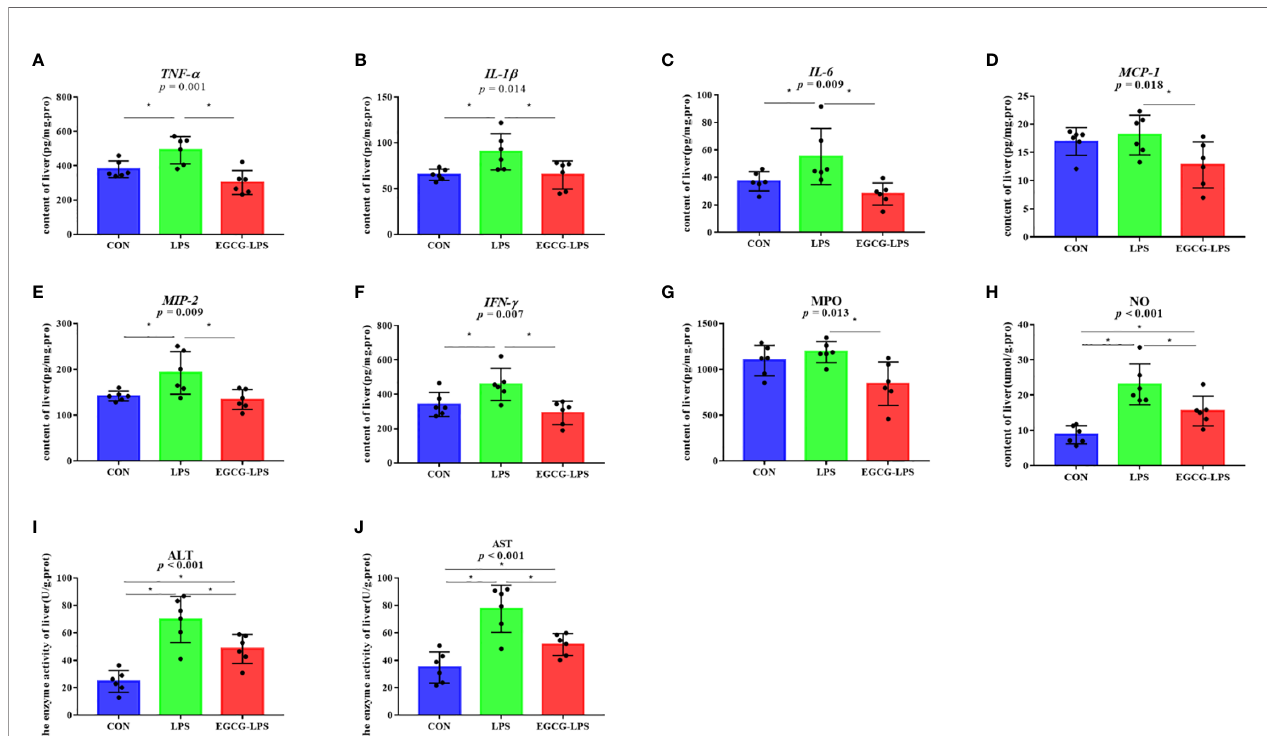
FIGURE 3 | The inhibition of the intragastric administration of EGCG on in fl ammation and oxidative stress in liver tissue. (A) the concentration of TNF- a in liver tissue; (B) the concentration of IL-1 b in liver tissue; (C) the concentration of IL-6 in liver tissue; (D) the concentration of MCP-1 in liver tissue; (E) the concentration of MIP-2 in liver tissue; (F) the concentration of IFN- g in liver tissue; (G) the concentration of MPO in liver tissue; (H) the concentration of total NO in liver tissue; (I) the enzyme activity of ALT in liver tissue; (J) the enzyme activity of AST in liver tissue. Data are mean ± SD (n = 6) and analyzed by one-way ANOVA. ” * ” means that the horizontal line connects the p -value of the data between the two groups <0.05, and the “ P ” value in the fi gure represents the accurate value of p between the three groups of data, and some of the p values between the three groups are too small to be expressed as p